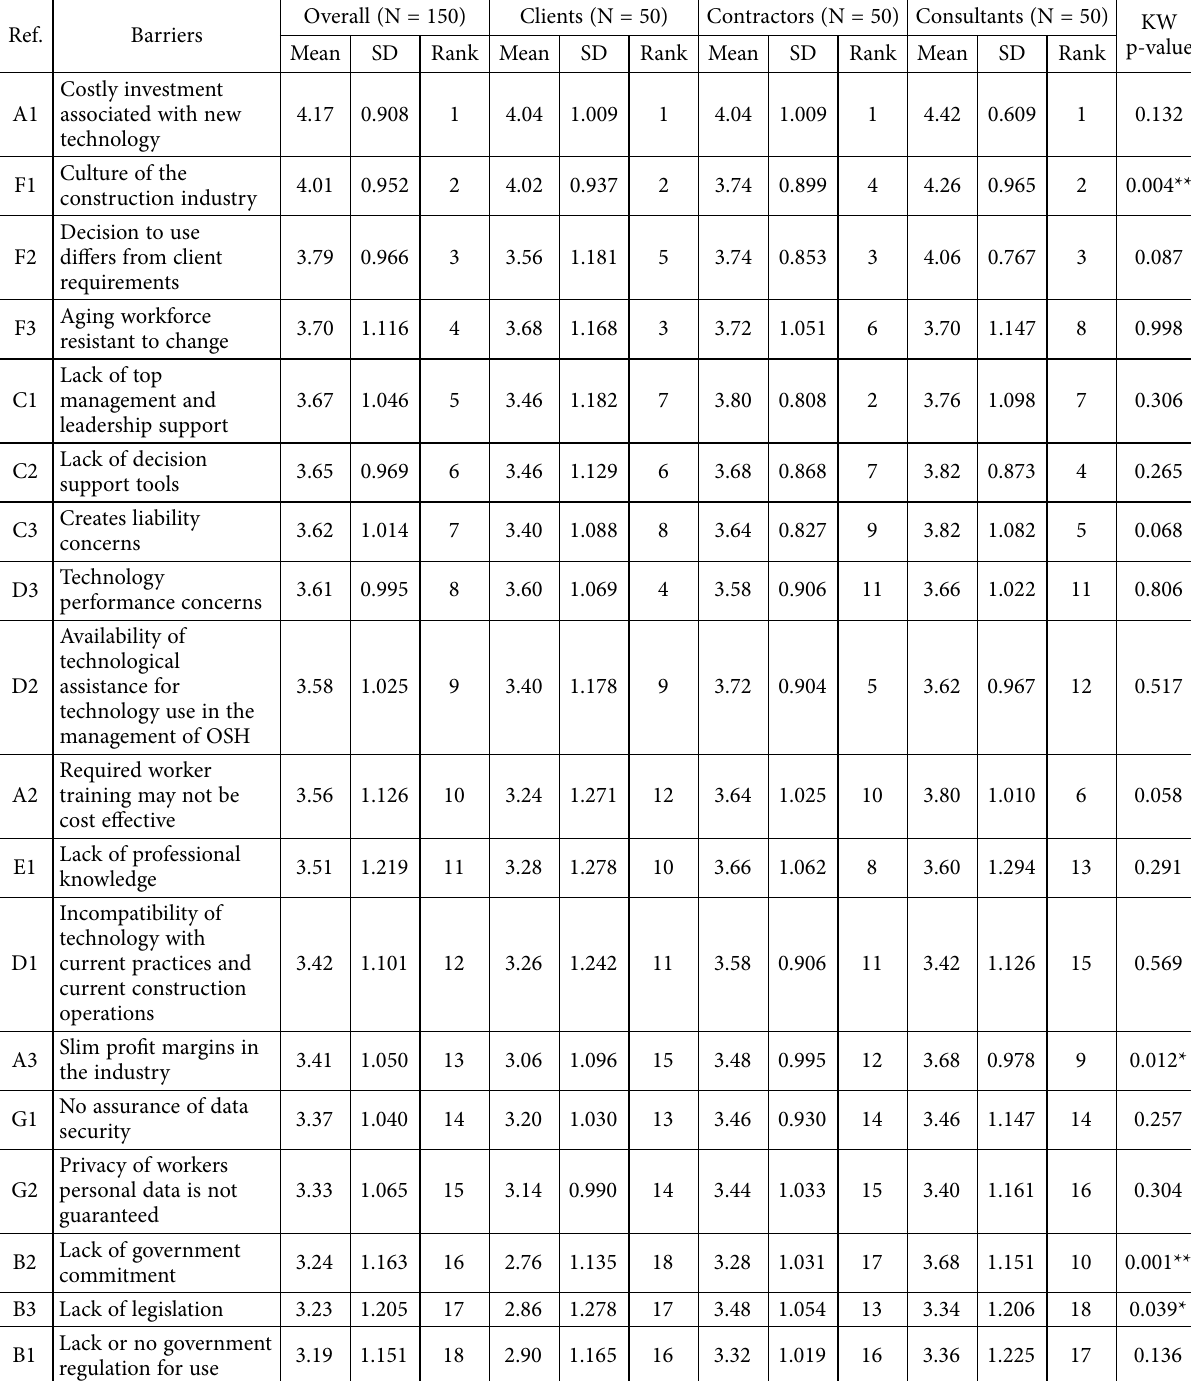
Table 3. Mean score and ranking of